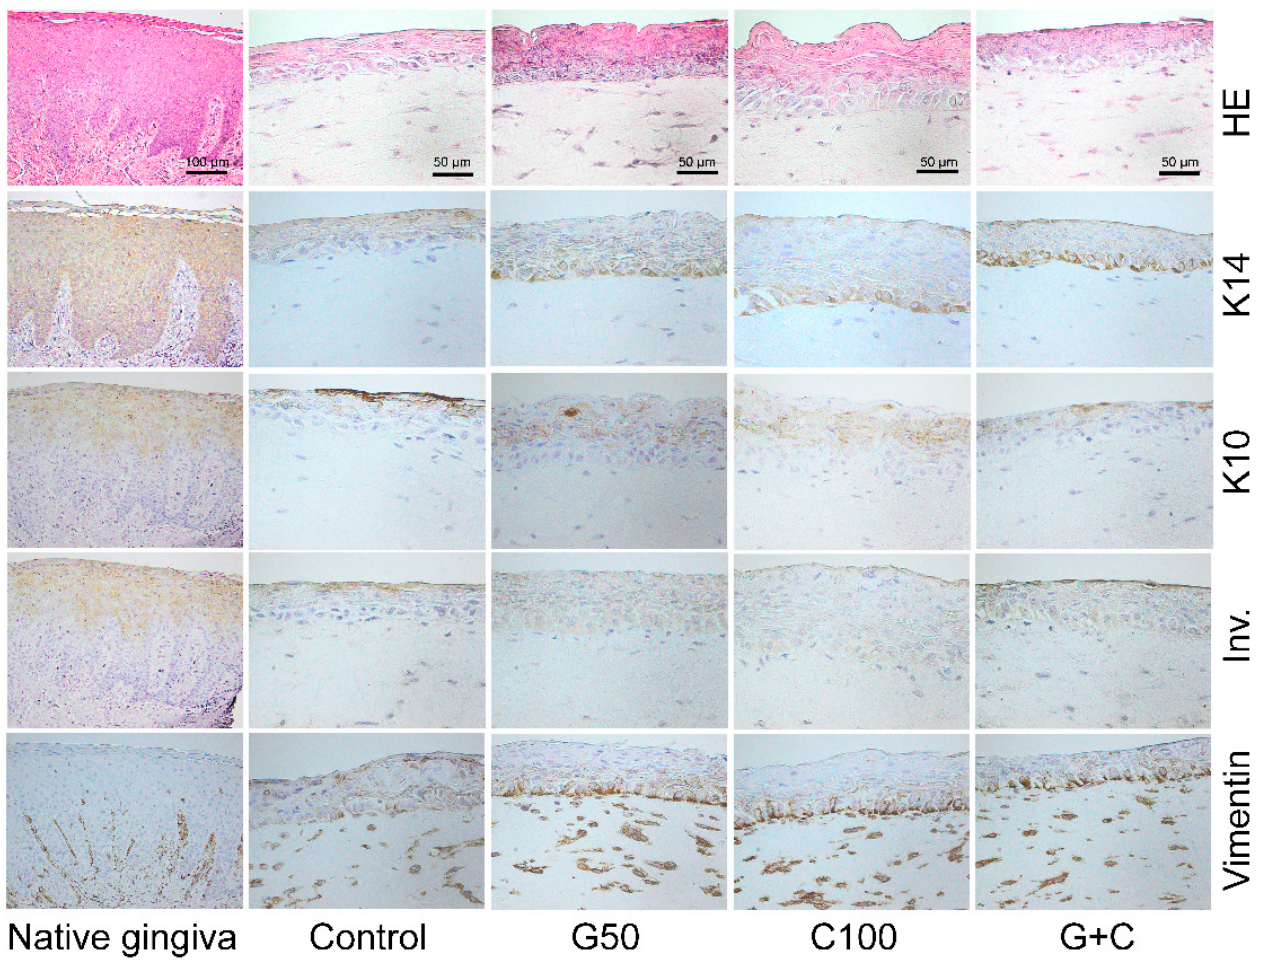
Figure 6. Immunohistochemical staining (5- µ m section) of HE, K14, K10, Inv., and vimentin in human 3D gingival tissue equivalents (GTEs) generated with TIGKs and hGFBs-populated collagen gel with/without genipin/cytochalasin D direct crosslinking for 2-week air–liquid interface culture. Abbreviations: hGFBs: hTERT-immortalized gingival fibroblasts; TIGKs: hTERT-immortalized gingival keratinocytes; G50: 50 µ M genipin; C100: 100 nM cytochalasin D; G + C: G50 + C100; HE: hematoxylin & eosin; K14: keratin 14; K10: keratin 10; Inv.: involucrin.